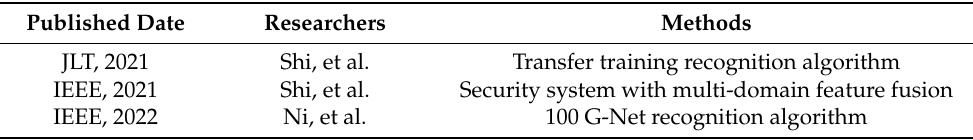
Figure 21. The classification algorithm flow [76]. Table 7. Summary of perimeter security applications.